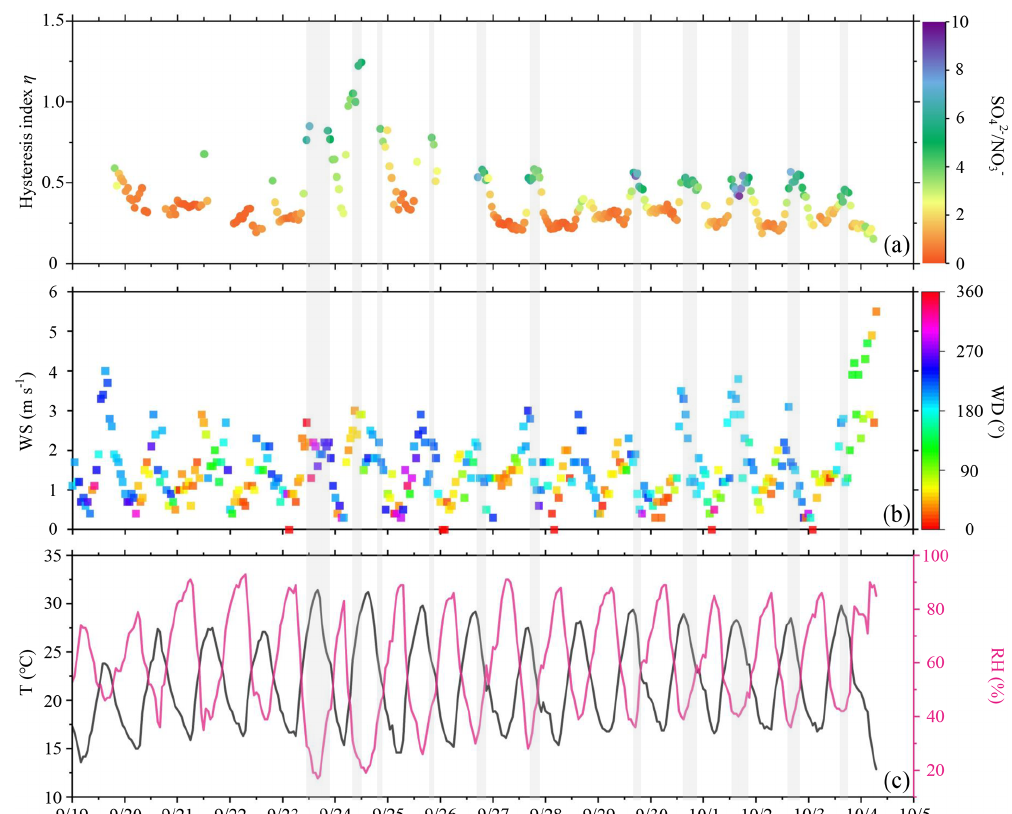
/ NO − mass concentration ratio, (b) wind speed (WS; unit: ms − 1 ) 4 3